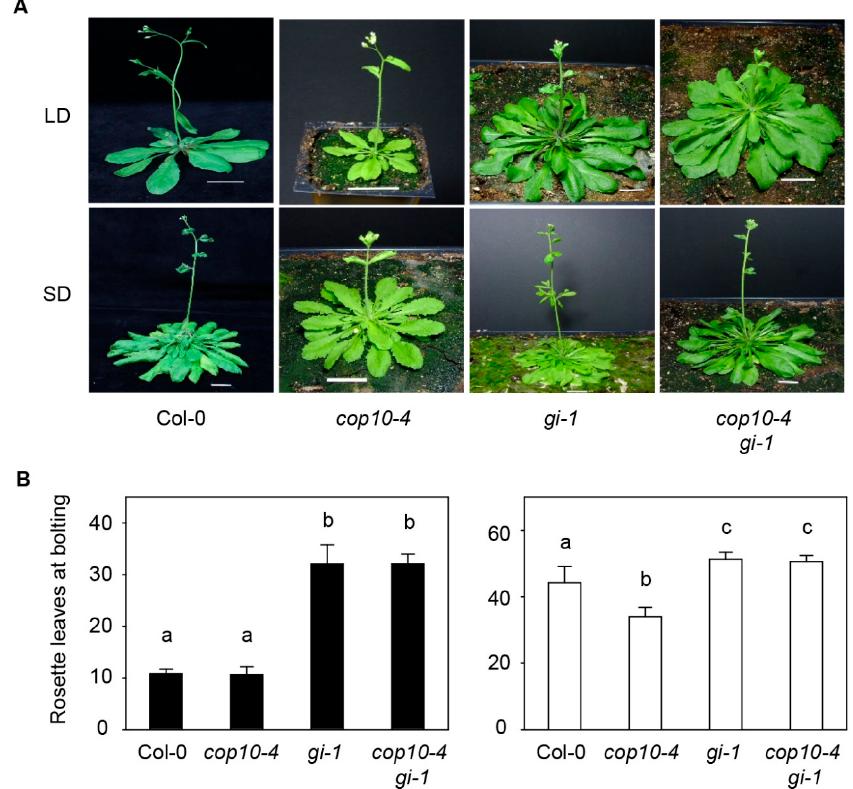
Figure 1. The early flowering phenotype of cop10-4 and gi-1 is epistatic to cop10-4 . Phenotypes ( A ) and the number of rosette leaves ( B ) of wild type (WT, Col-0 ecotype), cop10-4 , gi-1 , and cop10-4 gi-1 mutants in long days (LD) (black bars) and short days (SD) (white bars) Plants were grown at 22 °C under cool-white fluorescent light (90–100 μ mol·m − 2 ·s − 1 ) in LD (16-h light:8-h dark) or SD (10-h light:14-h dark), and photographed at two to four days after bolting. Scale bars = 2 cm; and ( B ) Flowering time was measured as the number of rosette leaves at bolting. Means and standard deviations were obtained from more than 20 plants. These experiments were repeated three times with the same results. Bars with different letters are significantly different according to Duncan’s multiple range test ( p < 0.05).